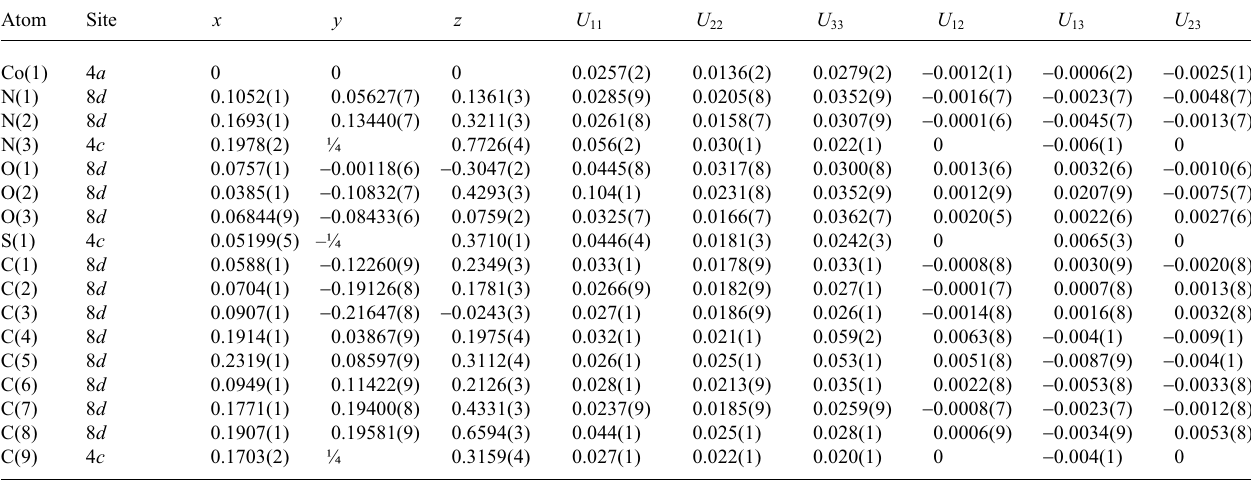
Table 3. Atomic coordinates and displacement parameters (in Å 2 )